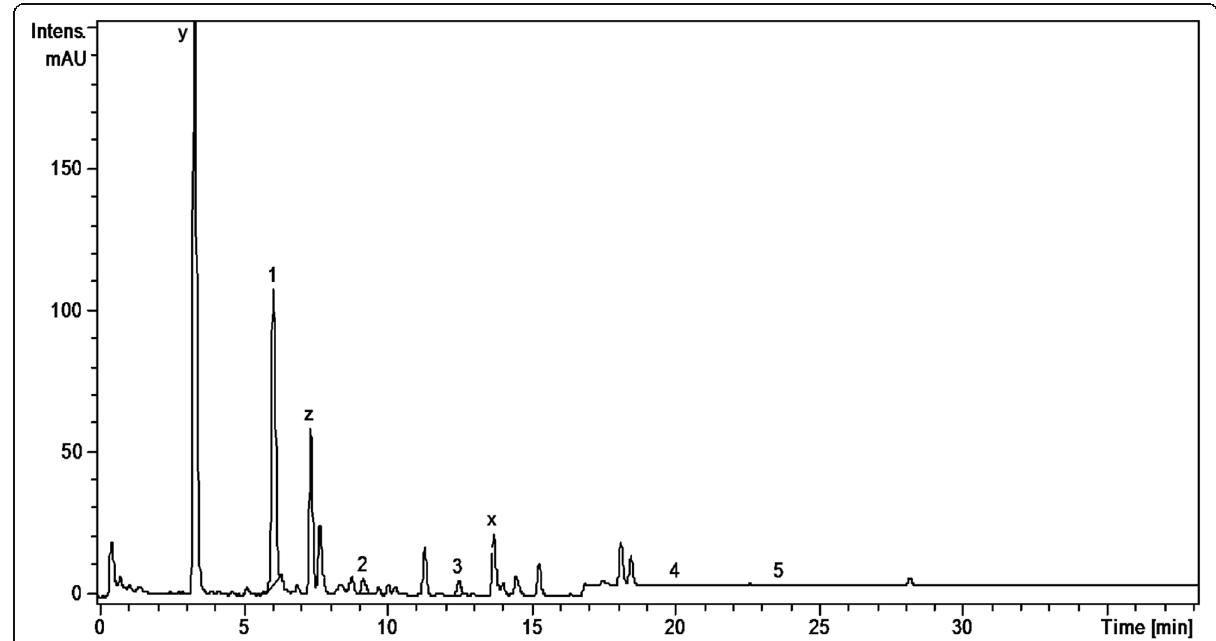
Fig. 2 HPLC chromatograms of N. poeticus extract. Notes: 1-chlorogenic acid; 2- p -coumaric acid; 3-ferulic acid; 4-isoquercitrin; 5-quercitrin